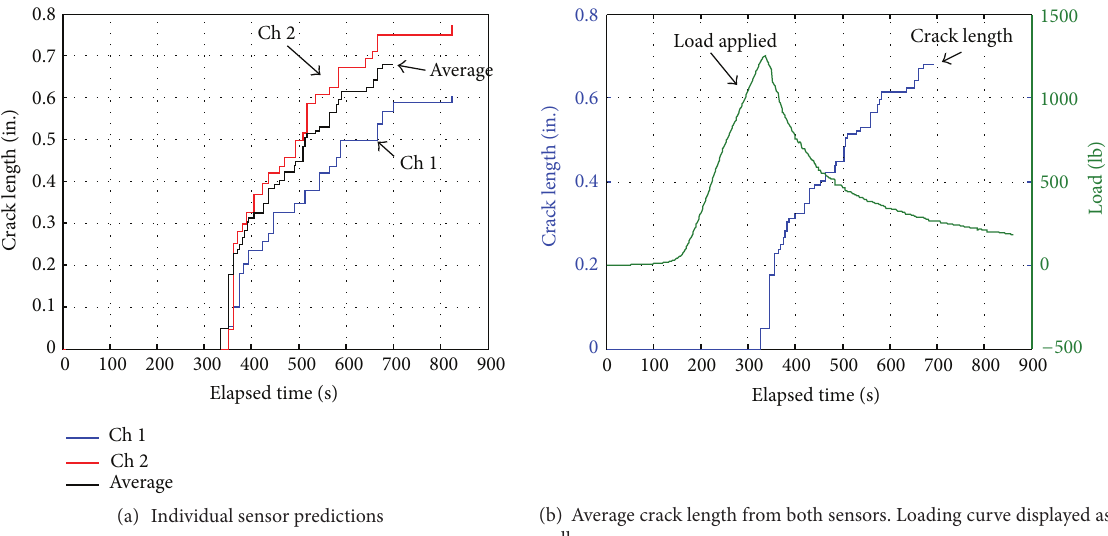
Figure 13: Crack growth length over time, approximated by neural